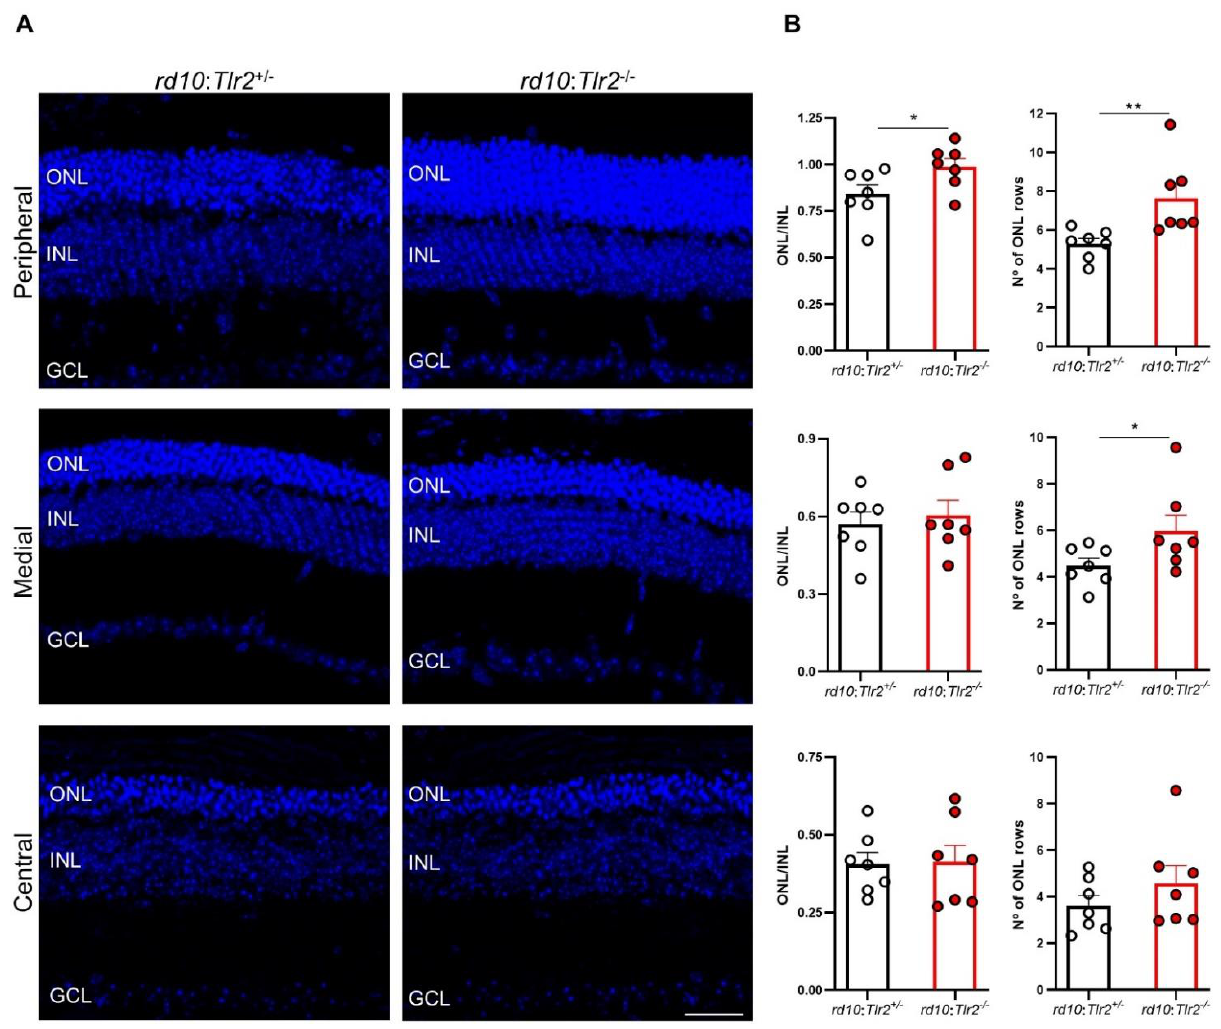
Figure 4. Retinal structure analysis of rd10 : Tlr 2 +/ − and rd10 : Tlr2 − / − mice. ( A ) Representative images of peripheral, medial, and central retinal areas in cryosections from rd10:Tlr2 +/ − and rd10:Tlr2 − / − mice at P36. Nuclei were stained with DAPI (blue). ONL, outer nuclear layer; INL, inner nuclear layer; GCL, ganglion cell layer. Scale bar, 31 µ m. ( B ) ONL and INL thickness was measured in equatorial sections corresponding to the peripheral, medial, and central retina (see Methods section). The number of photoreceptor rows was scored in the same regions. Dots represent individual mice, and bars represent the mean (+SEM) for each group. n = 7 animals per group, (5 sections per retina, 2 images per section in each area, 3 measurements per image). ** p < 0.01; * p < 0.05 (unpaired t -test for normally distributed data (ONL/INL ratio); Mann–Whitney U -test for non-normally distributed data (number of ONL rows)).